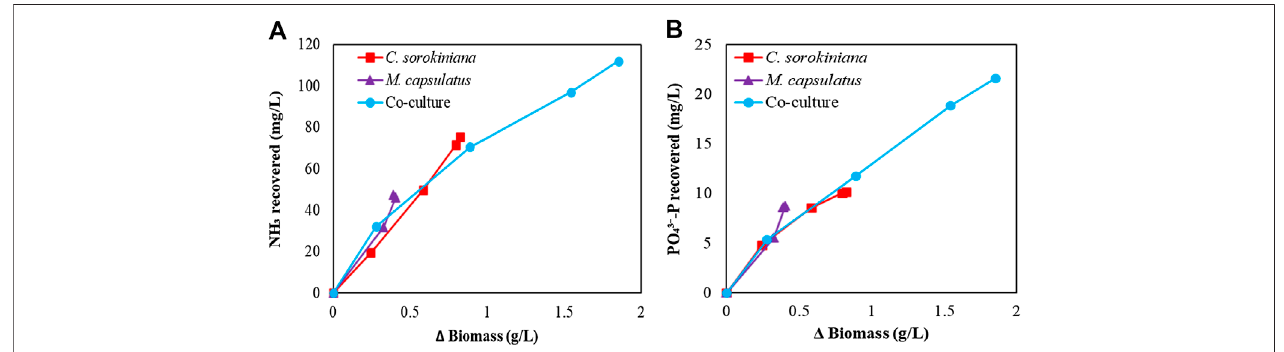
FIGURE 13 | Correlation of the biomass produced with the recovery of (A) NH 3 -N and (B) PO 43 − − P reveals that nutrient recovery is directly related to the biomass production and the enhanced nutrient recovery by the coculture is a result of the cocultures prolonged growth on biogas with no external oxygen supply.